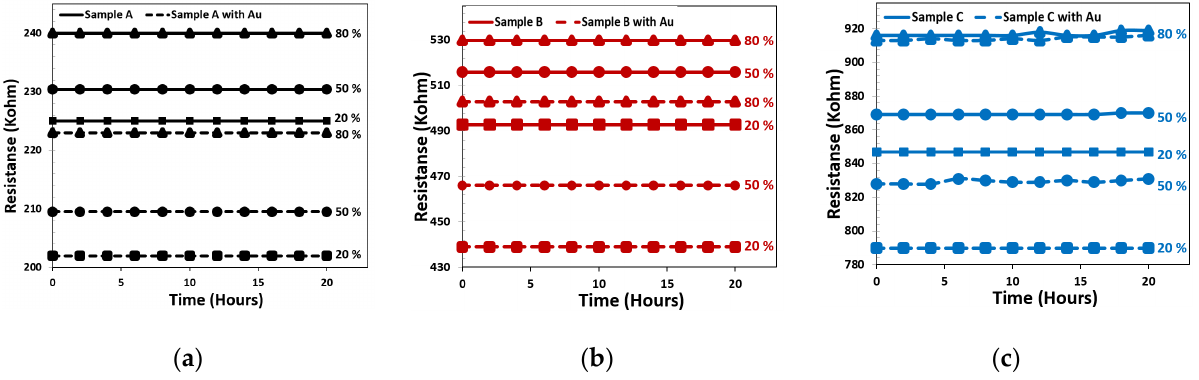
Figure 10. The short-term stability of CNF-based sensors, measured at 1V at various RH levels. The thermodynamic of gas adsorption that is related to temperature affects CNF gas detection. The conductivity of the CNF devices decreases by increasing the temperature to 100 ◦ C. As shown in Figure 11, when exposed to ethanol vapor at elevated tempera- tures, the CNF response to analytes again increases. Increasing the temperature